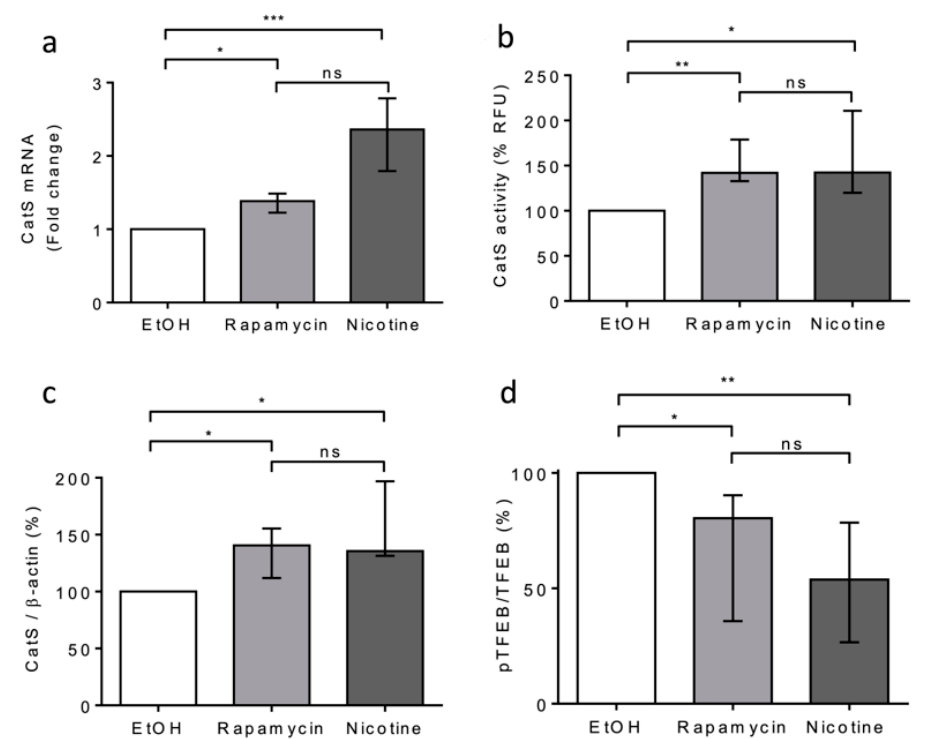
Figure 4. Nicotine-elicited upregulation and secretion of active CatS through the mTOR/TFEB signaling pathway in THP-1 macrophages. ( a ): THP-1 macrophages were treated with nicotine (5 µM) or rapamycin (50 nM) during 12 h and then lysed. CatS transcription was analyzed by RT-qPCR. Data are expressed as relative percentage compared to the untreated control (EtOH). ( b ): Enzymatic activity of secreted CatS was measured in supernatants of THP-1 cells. ( c ): Densitometric analysis of the mature CatS. Normalized data correspond to the average of five independent Western blot experiments ( β -actin, load control). ( d ): Densitometric analysis of the pTFEB/TFEB ratio. Normalized data correspond to the average of five independent Western blot experiments. Bars represent median ± quartile. Statistical significance was assessed using Kruskal–Wallis test (* p < 0.05; ** p < 0.01; *** p < 0.001). ns: not significant.